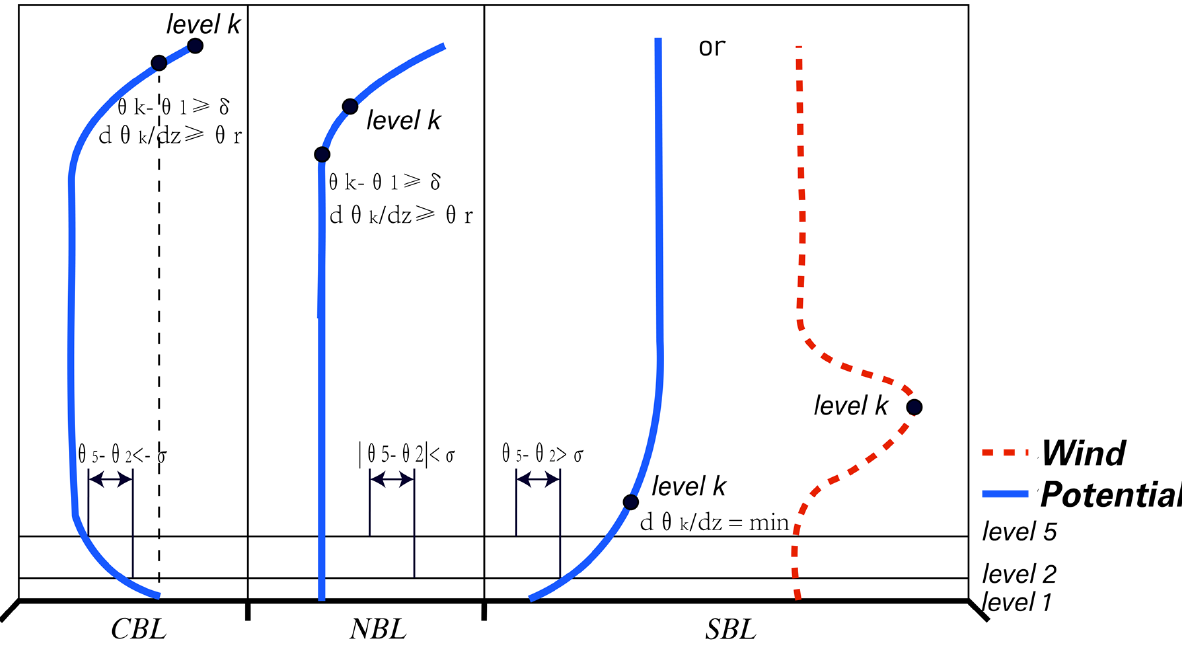
Figure 3. Schematic diagram of potential temperature profile method. The blue line represents the vertical distribution of the potential temperature, and the red dotted line represents the vertical distribution of the wind speed adapted with permission from Ref. [49].